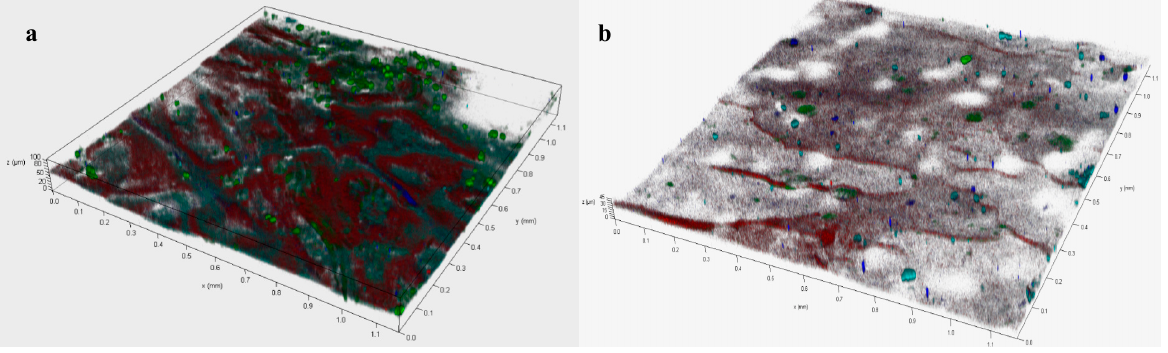
Figure 4. Images of the fouled MF membranes obtained from confocal laser scanning microscope (CLSM) at different operating modes of constant flux ( a ) and varying flux ( b ). Table 2. Biovolume of the biofoulants on the fouled MF membranes at different operating modes calculated by